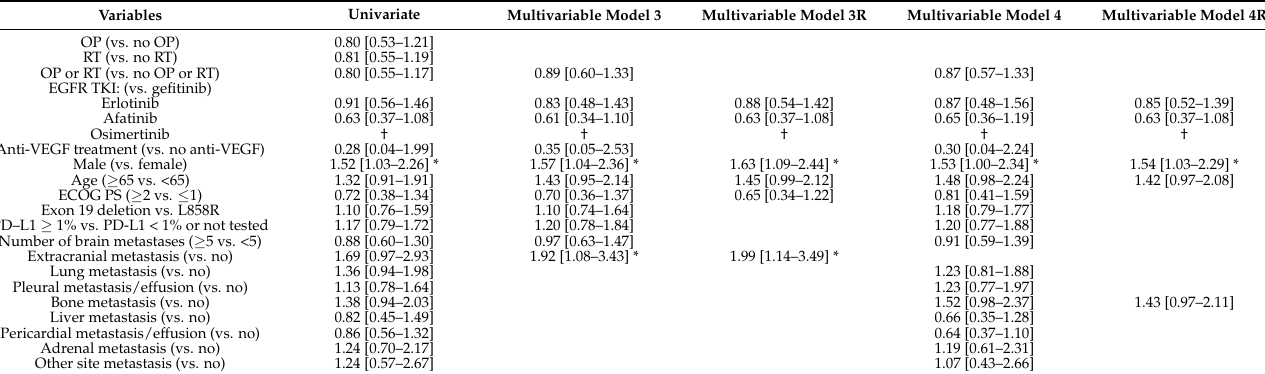
Abbreviations: ECOG, Eastern Cooperative Oncology Group; EGFR, epidermal growth factor receptor; OP, surgery for brain tumor; PD-L1, programmed death ligand 1; PS, performance status; RT, radiotherapy for brain tumor; TKI, tyrosine kinase inhibitor; VEGF, vascular endothelial growth factor. A patient with cancer harboring both the exon 19 deletion and L858R was included in the exon 19 deletion group. Data are presented as hazard ratio (HR) with 95% confidence interval. After building the maximal models of multivariable Cox regression (models 3 and 4), the corresponding reduced multivariable Cox regression models (models 3R and 4R, respectively) were built using backward variable selection, retaining only variables with p -values < 0.15. † HR could not be assessed due to no event in a group. * p -value <